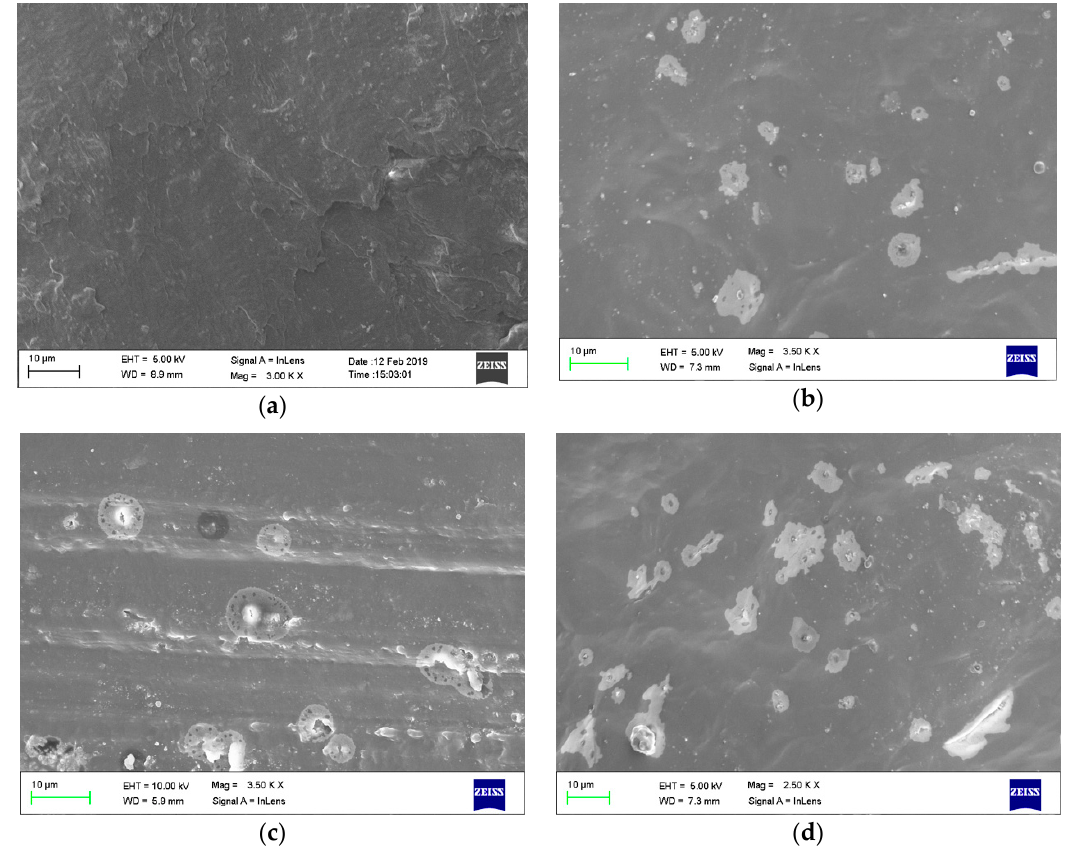
Figure 3. Field emission scanning electron microscope (FESEM) images of ( a ) pure paraffin, ( b ) 0.5 HnP, ( c ) 1.0 HnP, and ( d ) 2.0 HnP.